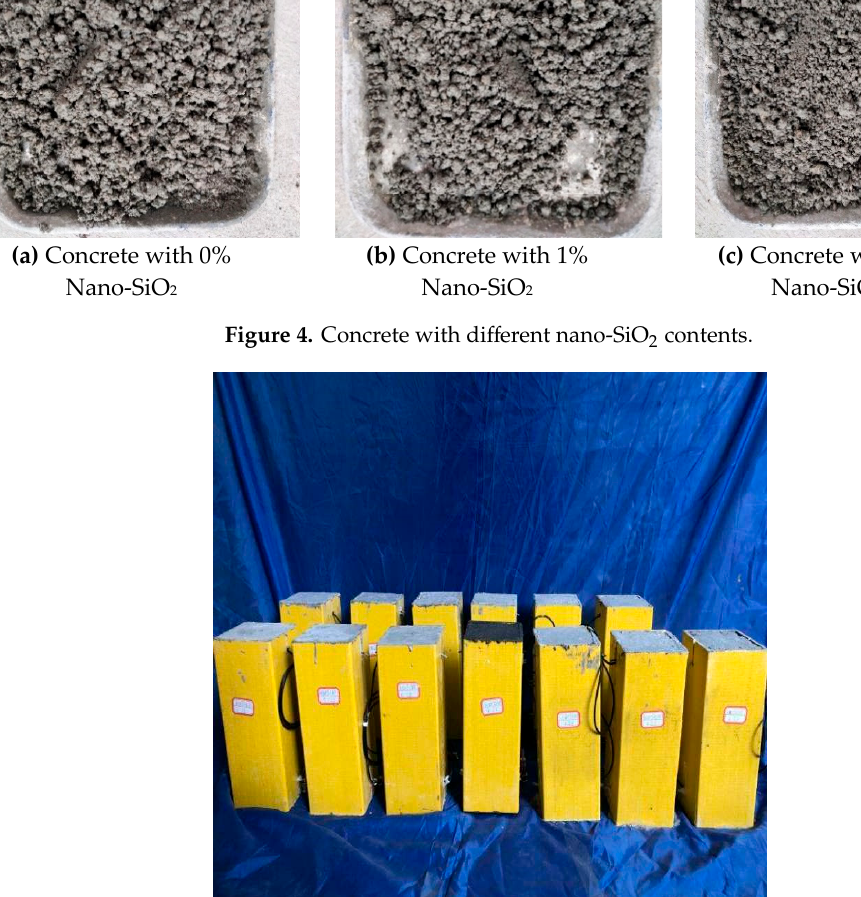
Figure 5. Short GFRP tube concrete column with nano-SiO 2 .